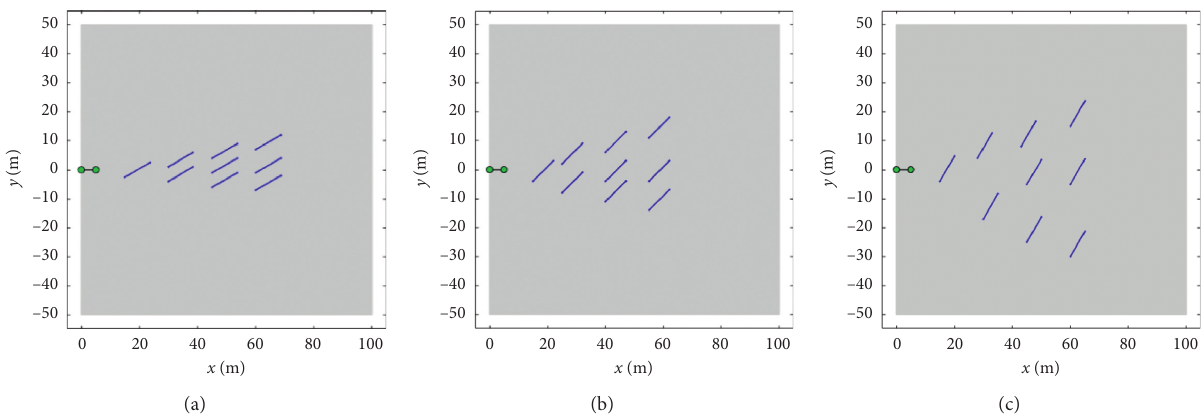
Figure 6: Initial fracture distribution. (a) Initial crack distribution, 30 ° . (b) Initial crack distribution, 45 ° . (c) Initial crack distribution, 60 ° .